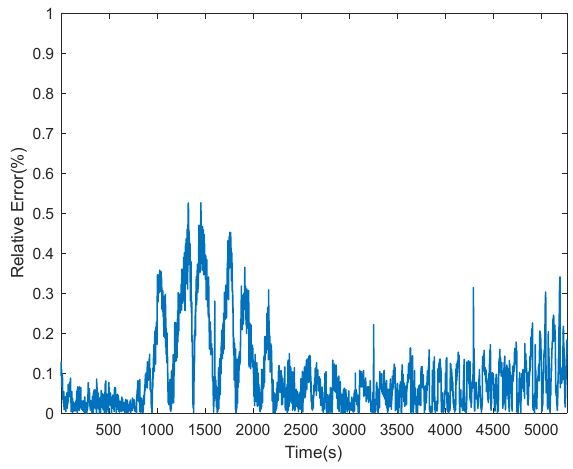
Figure 6. Relative error during low-current charging.